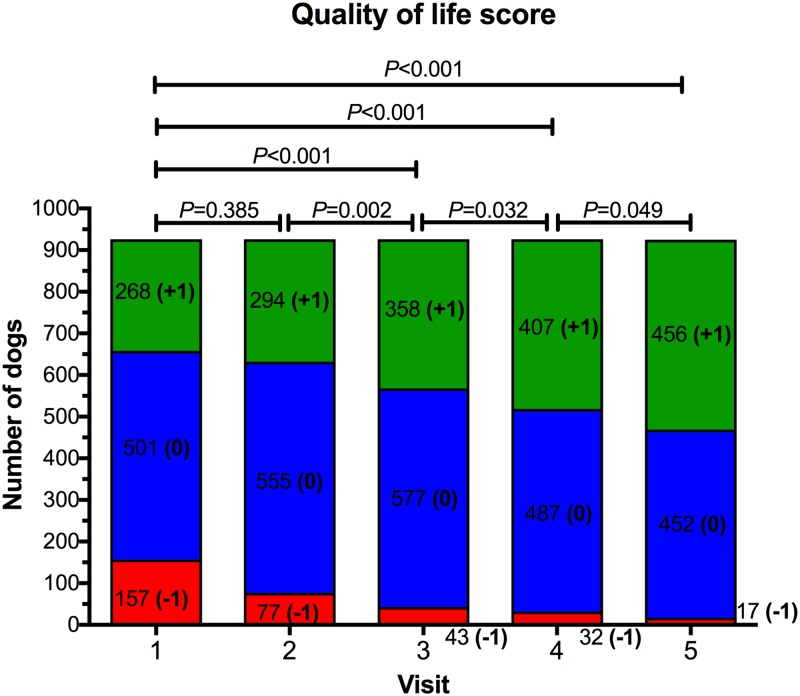
Quality of life (QOL) scores for dogs during the study.QOL was subjectively determined at each visit after a discussion between the veterinarian and owner (Table 3). At each visit, blocks with different colours represent the proportion of dogs assigned a QOL score of -1 (red), 0 (blue) and 1 (green), respectively. The number of dogs assigned to each category is also shown.